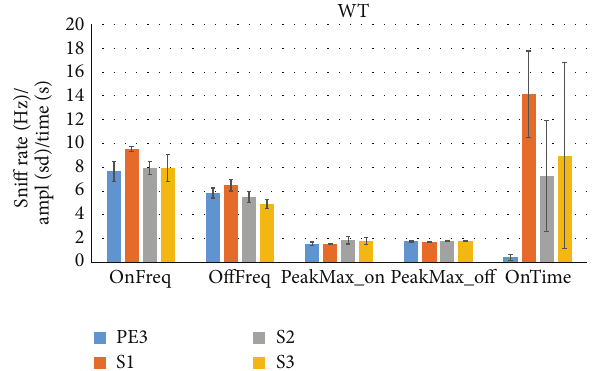
Figure 1: The sniff rate increases during cross-habituation in female wild type (WT) mice. A cotton tip odorized with phenyl ethanol (PE) or mouse urine as social odor (S) was presented 3 times during the habituation/cross-habituation test (HaXha). PE3 represents the 3rd presentation of PE and S1 the 1st presentation of S. The time exploring the odorant (OnTime) by WT mice (129 strain, 𝑛 = 7 ) was scored in real-time by Noldus video tracking system based on the standard criteria of nose proximity ( < 2 cm) and head orientation ( < 20 ∘ ) to the odor source. The simultaneously plethysmographically measured sniff rate was measuring while exploring (OnFreq) and not exploring (OffFreq), as was the sniff amplitude (PeakMax on andPeakMax off,resp.).IncreasedexplorationtimeduringS1shows cross-habituation and was accompanied by an increase in the sniff rate. OnFreq and OffFreq: sniff rate (Hz); PeakMax on and PeakMax off: sniff peak amplitude (standard deviations of 𝑧 -scored pressure signal). OnTime: odor object exploration time (s). All data are mean ± SEM.